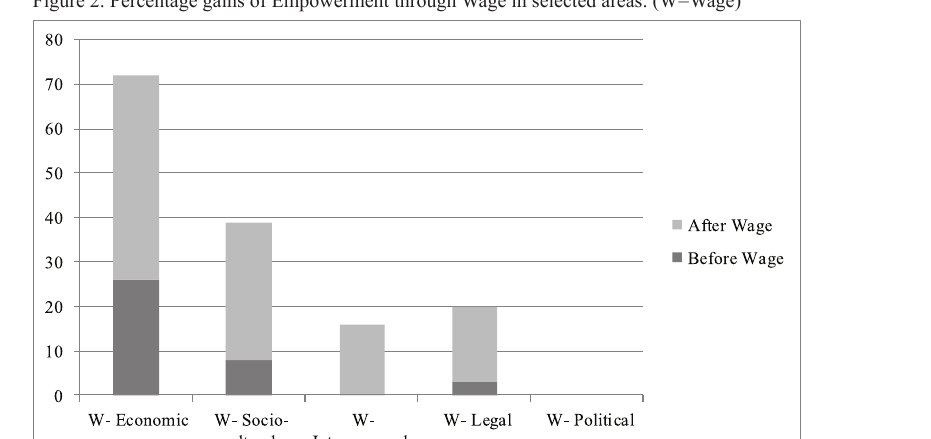
Figure 2. Percentage gains of Empowerment through Wage in selected areas. (W=Wage)